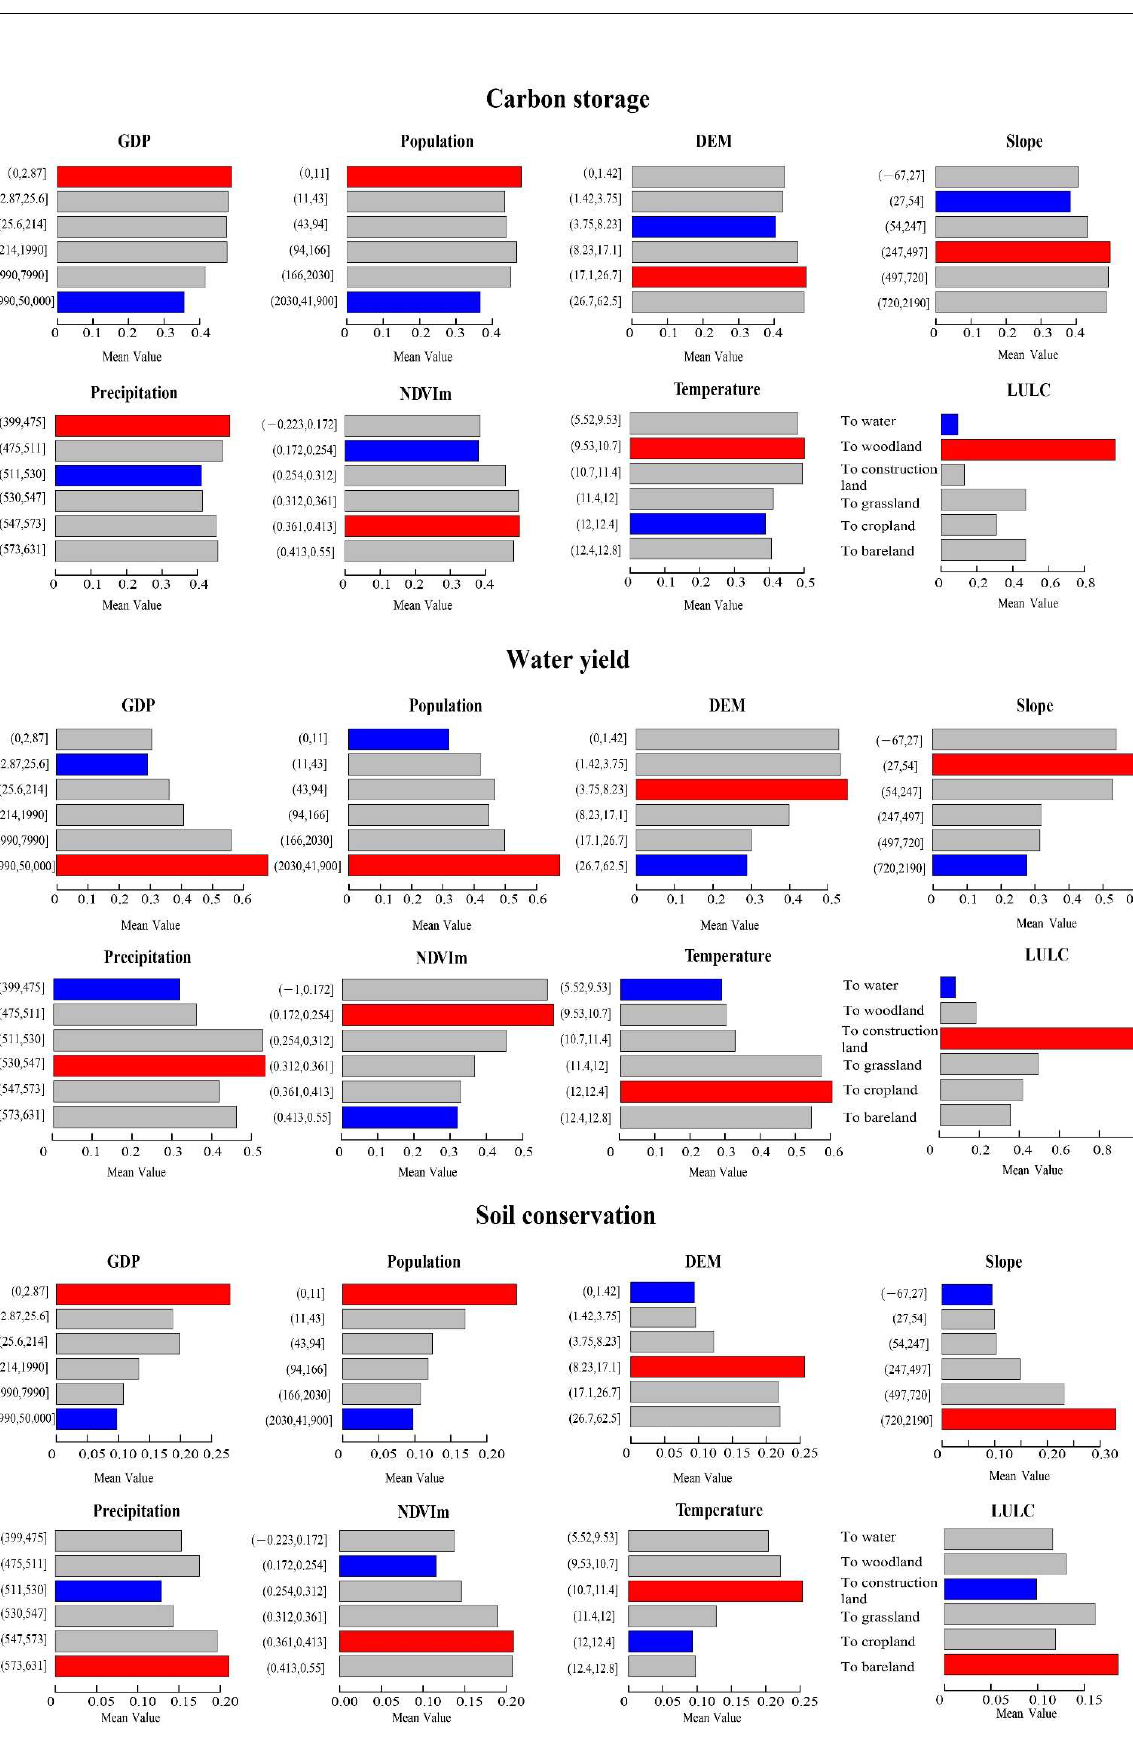
Figure 6. The impact of driving factor classification categories on changes in